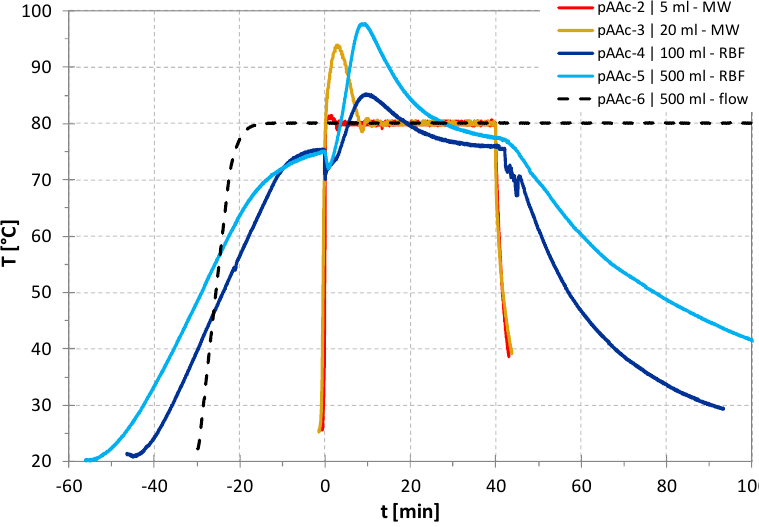
Figure 3. Temperature profiles of RAFT polymerizations of AAc in various batch reactors (MW = Biotage microwave reactor, RBF = round bottom flask) and in the continuous flow reactor; for the MW reactions t = 0 corresponds to the point where the temperature of the solution reaches ~80 °C; for the RBF reactions t = 0 corresponds to the addition of initiator to the previously heated up monomer solution; for the continuous flow reaction t = 0 corresponds to the change-over from pumping solvent to pumping monomer solution into the reactor (see also text